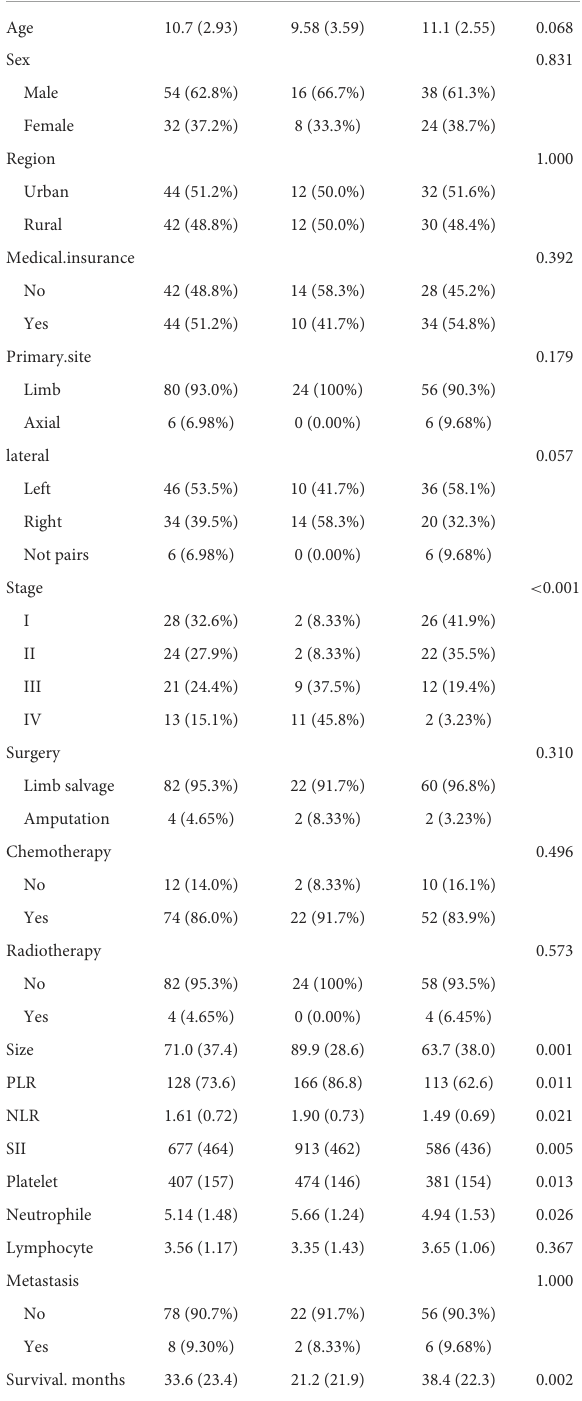
TABLE 1 Clinicopathological characteristics of children with